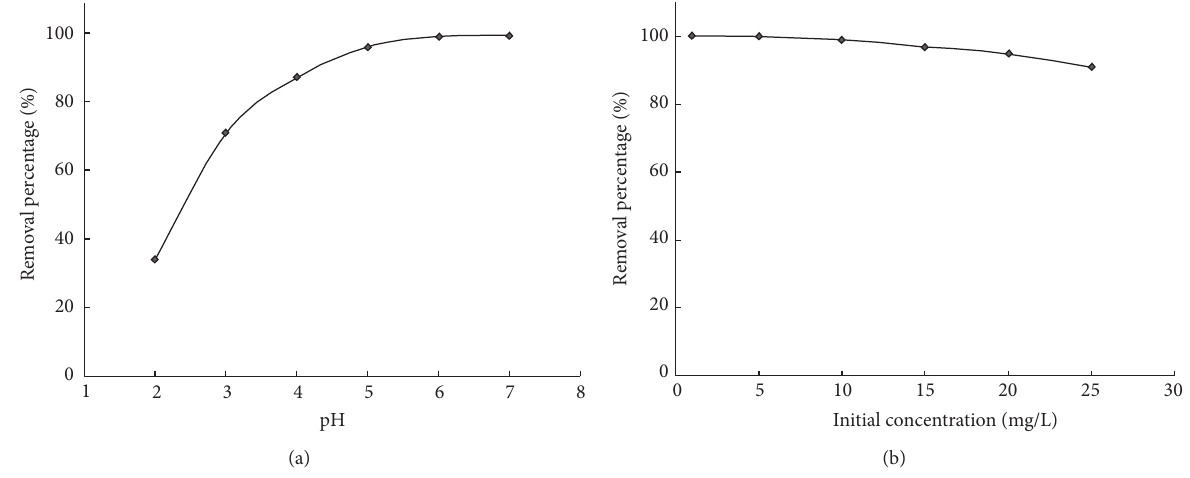
Figure 8: Effect of (a) pH and (b) initial concentration of Cu(II) on the removal percentage of Cu(II).